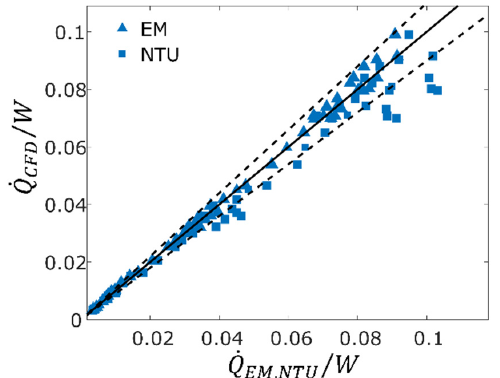
Figure 12. Comparison of the transferred heat as predicted by CFD analysis ( y -axis) and the P-NTU method or the effective heat transfer (EM) model ( x -axis). Legend: analysis point, — parity, --- ±10% deviation.